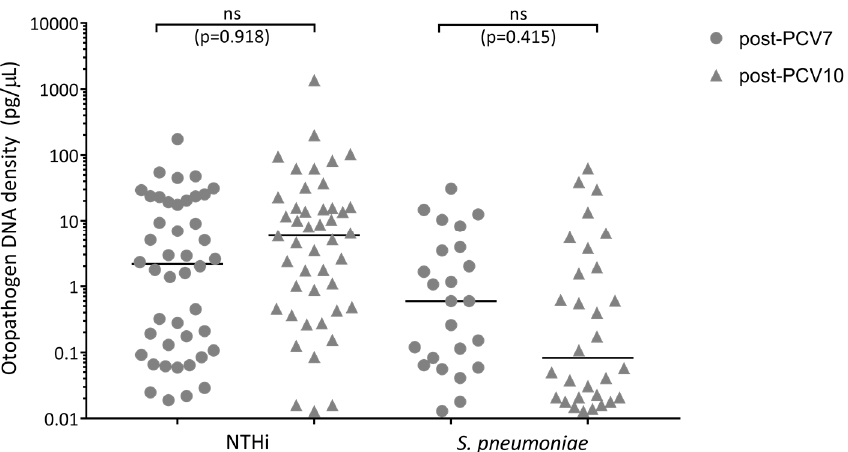
Figure 2. Otopathogen density in the middle ear of PCV7- and PCV10-vaccinated otitis-prone children with pneumococcal or NTHi OM. Data are presented for each child with an otopathogen detected in their middle ear, with each data point representing an individual child and the horizontal bars depicting the median otopathogen DNA concentration in pg/ μ L in the middle ear effusion. Circles represent PCV7-vaccinated otitis-prone cases and triangles represent PCV10-vaccinated otitis-prone cases. Statistical analysis was conducted on adjusted data, correcting for age and day-care attendance, ns: not significant. NTHi, nontypeable Haemophilus influenzae ; PCV, pneumococcal conjugate vaccine.